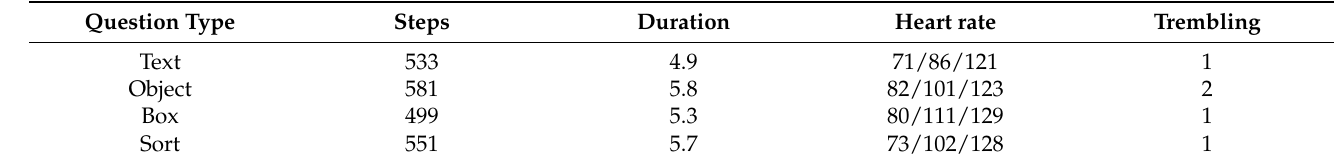
Table 5. Average results of different challenges in 10 sessions for 18 users aged 20–40.